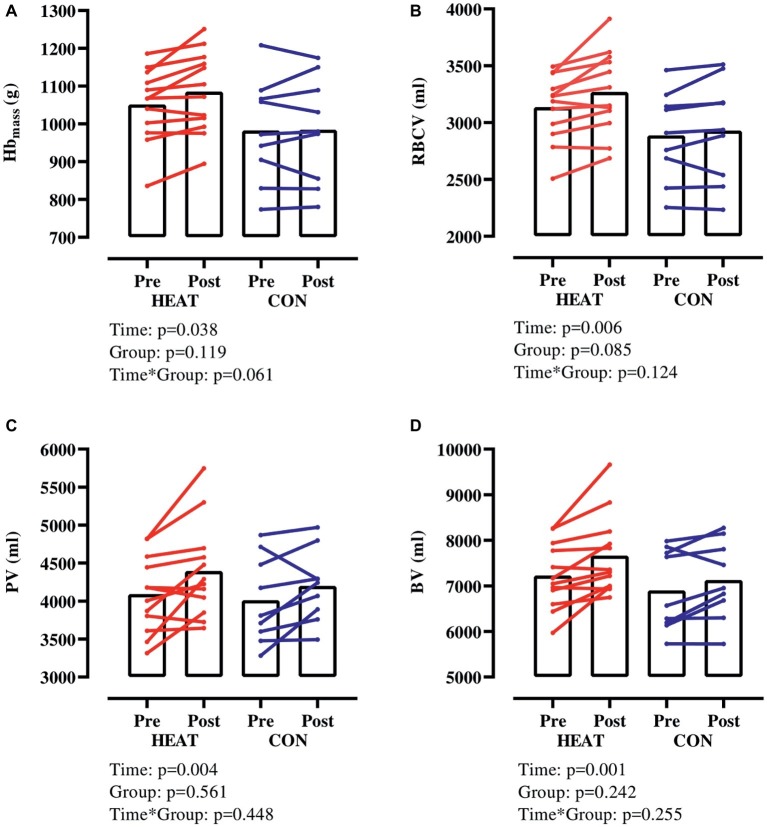
Hbmass and intravascular volumes with exercise-heat acclimation (HEAT) or matched control training (CON). (A) hemoglobin mass (Hbmass), (B) red blood cell volume (RBCV), (C) plasma volume (PV), (D) blood volume (BV).